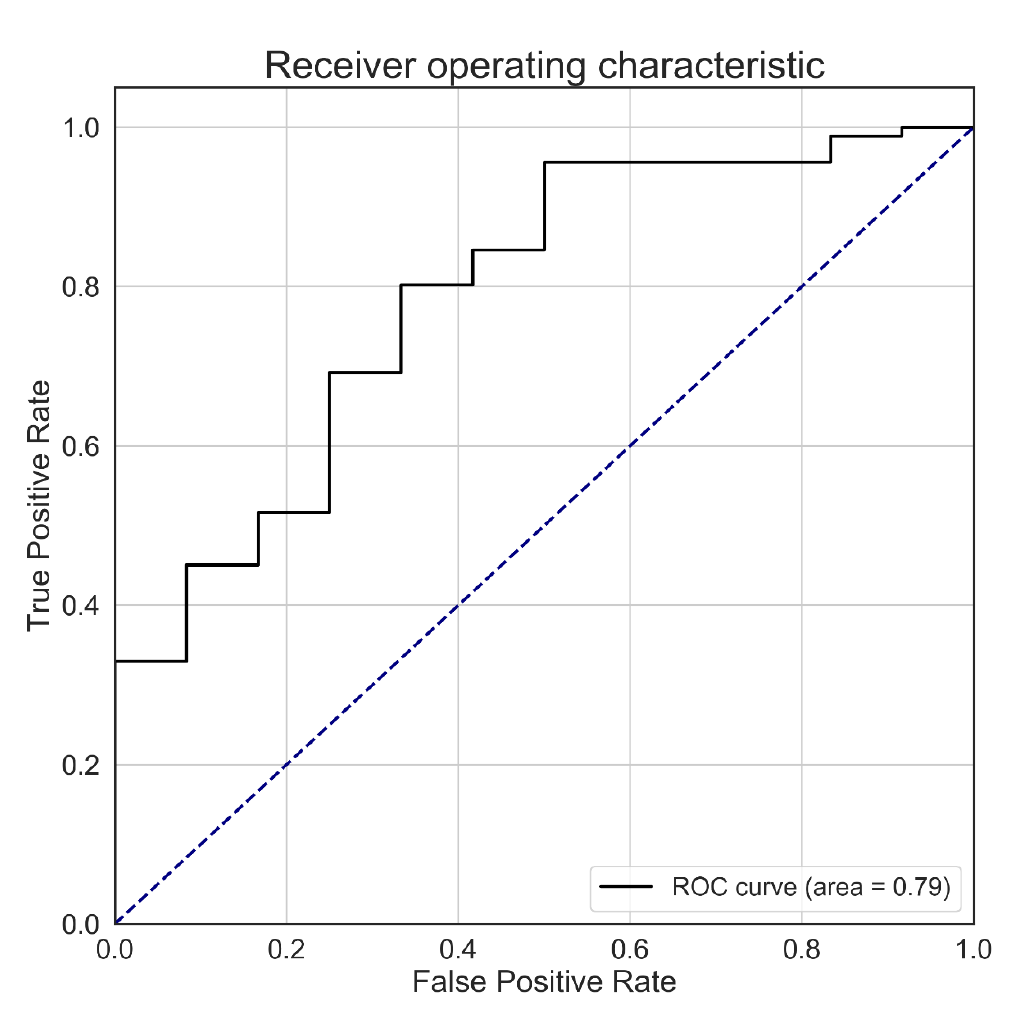
Figure A2. The ROC curve used to determine the optimal threshold value for predicting the occurrence of glossy buckthorn. A Pareto front was used to determine the fraction of glossy buckthorn that allows one to minimize the false negative rate and maximize the true positive rate. The black line describes the behavior of the ROC algorithm for all possible threshold values, while the blue dashed line represents a random classifier with no power of